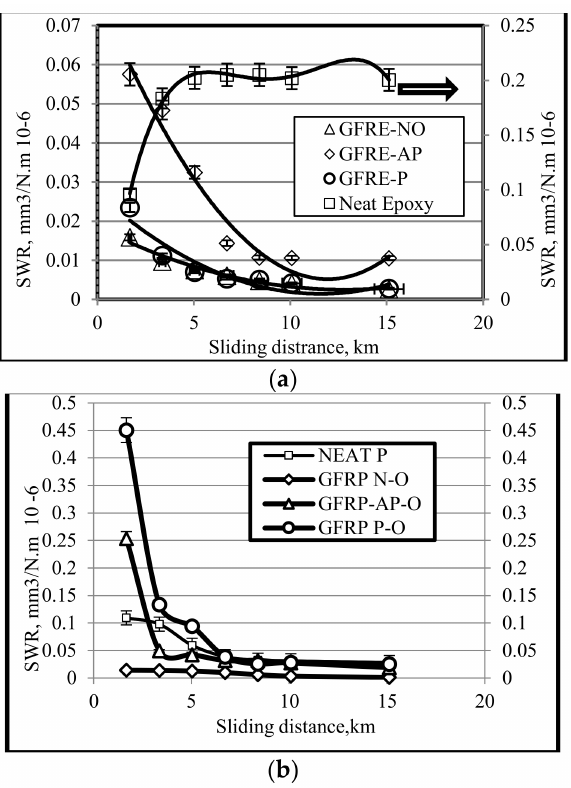
Figure 4. The variation in the SWR as a function of sliding distance for ( a ) NE and GFRE and ( b ) NP and